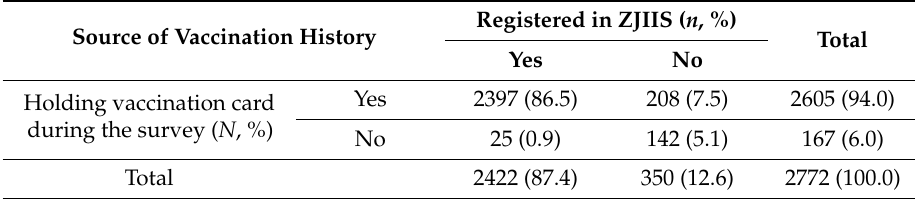
Table 2. Source of obtained vaccination history of the 2772 children in the 2014 coverage survey, Zhejiang province.